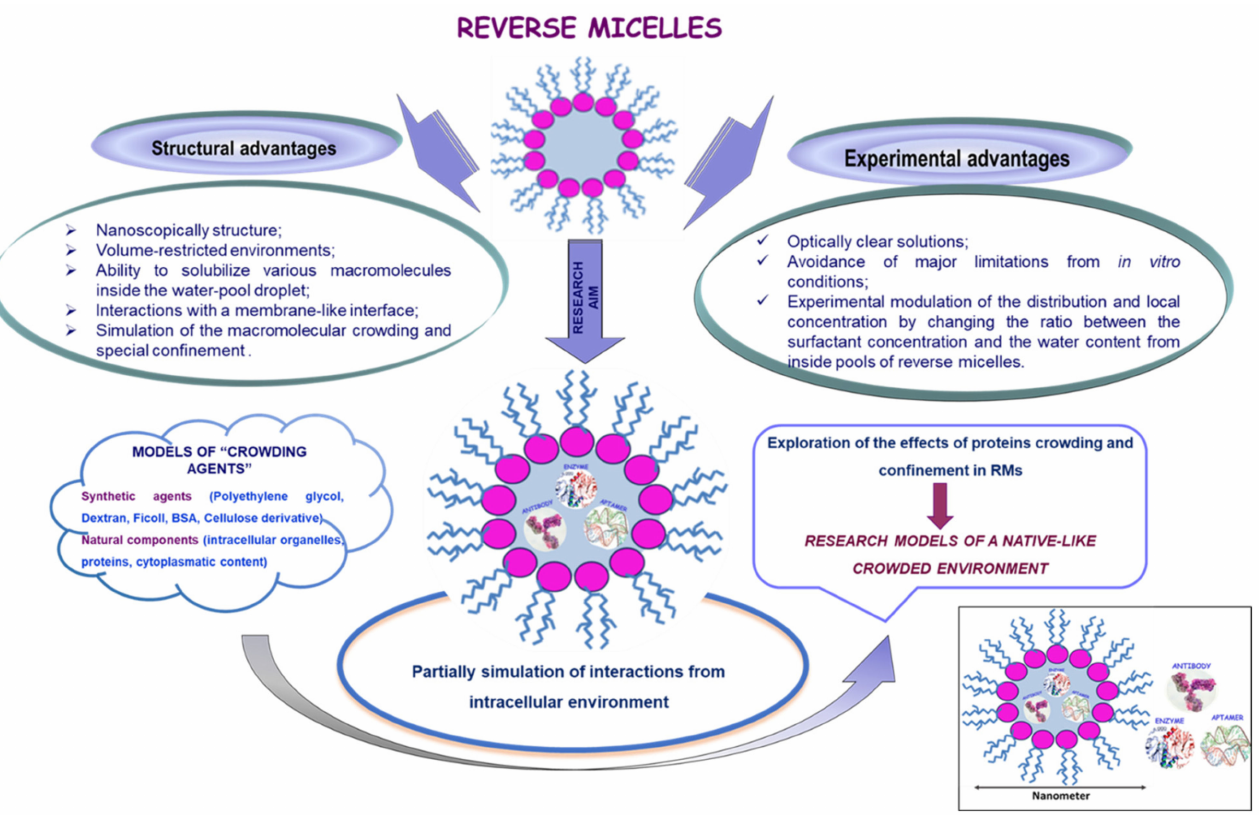
Figure 8. Reverse Micelles—models of native-like crowded